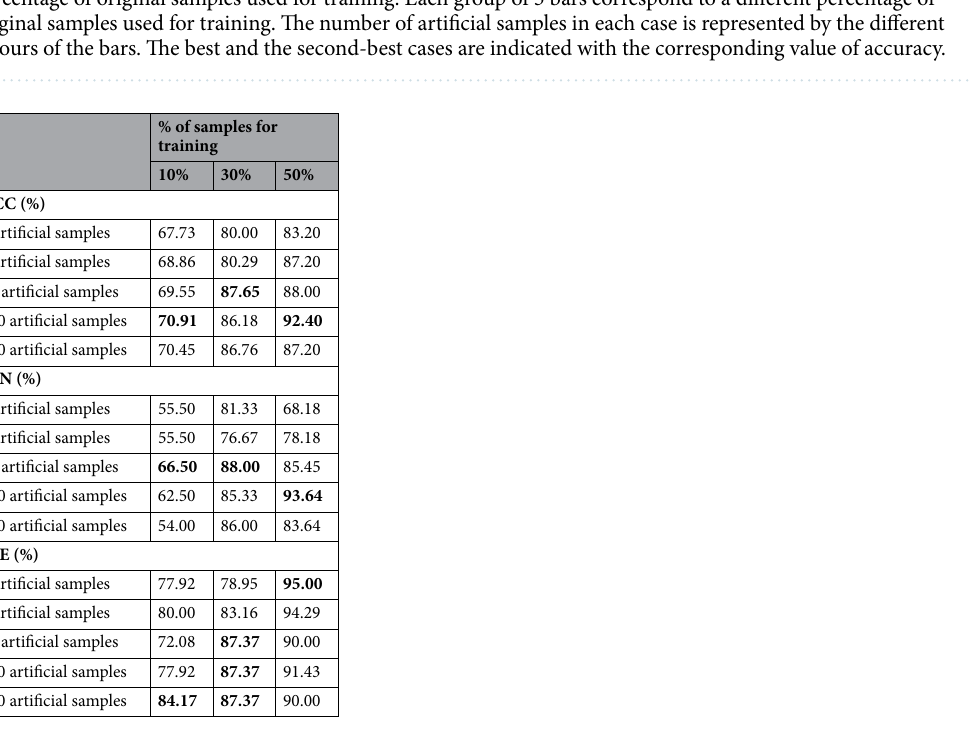
Table 4. Accuracy, sensitivity and specificity of the testing diagnosis depending on the number of artificial samples and the percentage of original samples used for training. Best cases are highlighted in bold.